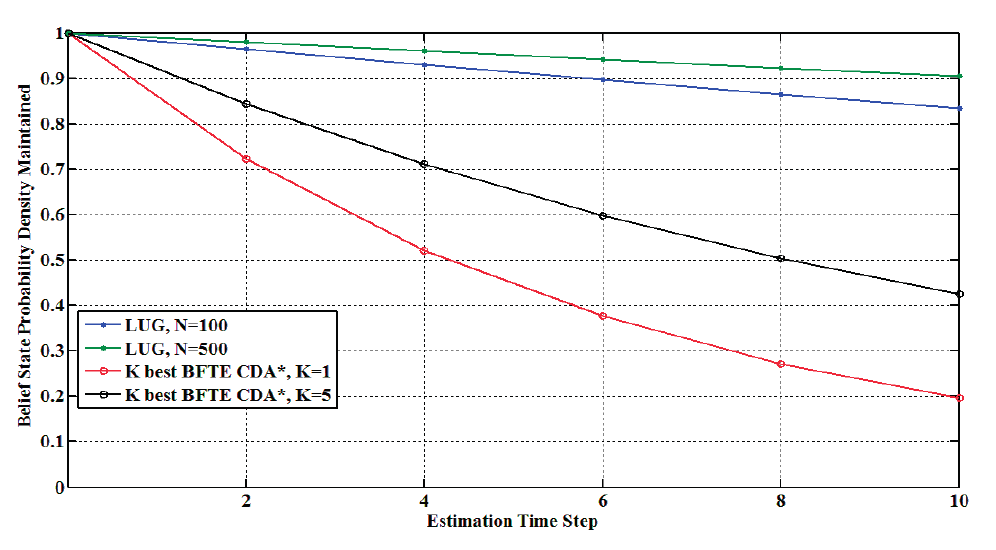
Figure 8. Probability density maintained over